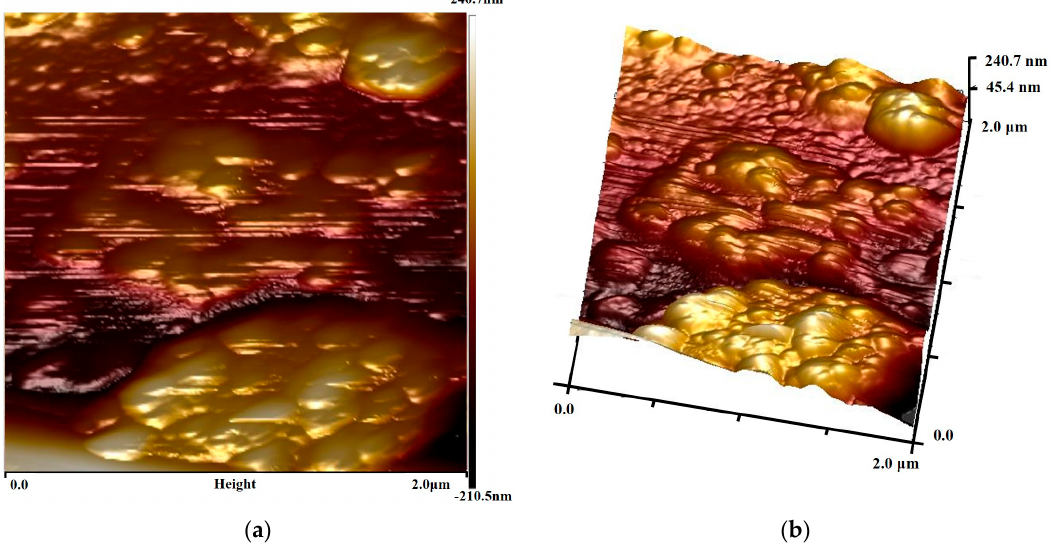
Figure 8. AFM ( a ) 2D and ( b ) 3D images of bacterial adsorption at 16 h.